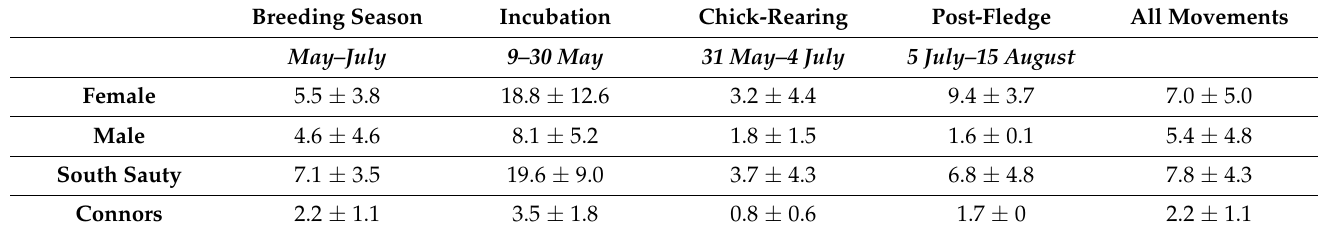
Table 4. Means and standard deviation (SD) of 50% core use areas (km 2 ) of Double-crested Cor- morants on Guntersville Reservoir for female, male and colony affiliation by breeding periods (in bold first column and top